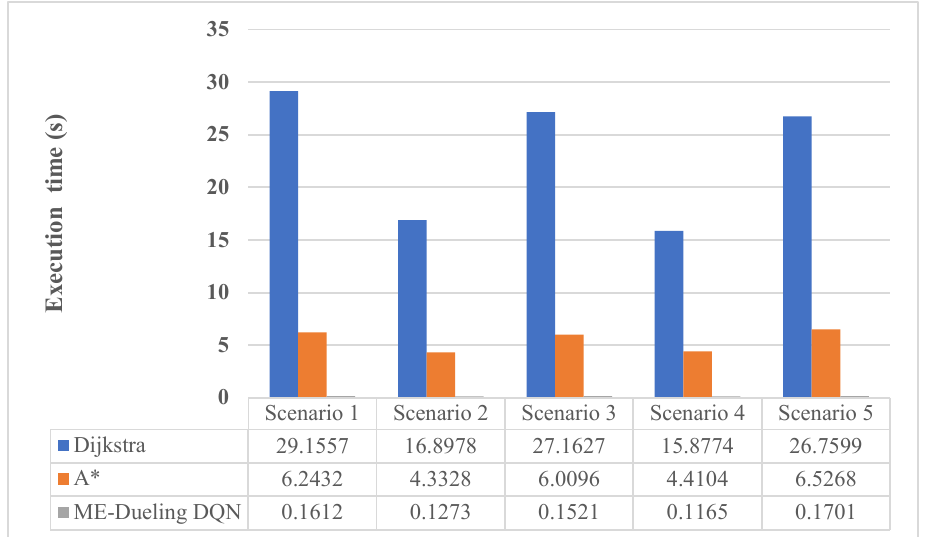
Figure 18. Comparison of execution time for Dijkstra, A* and ME-Dueling DQN algorithms.